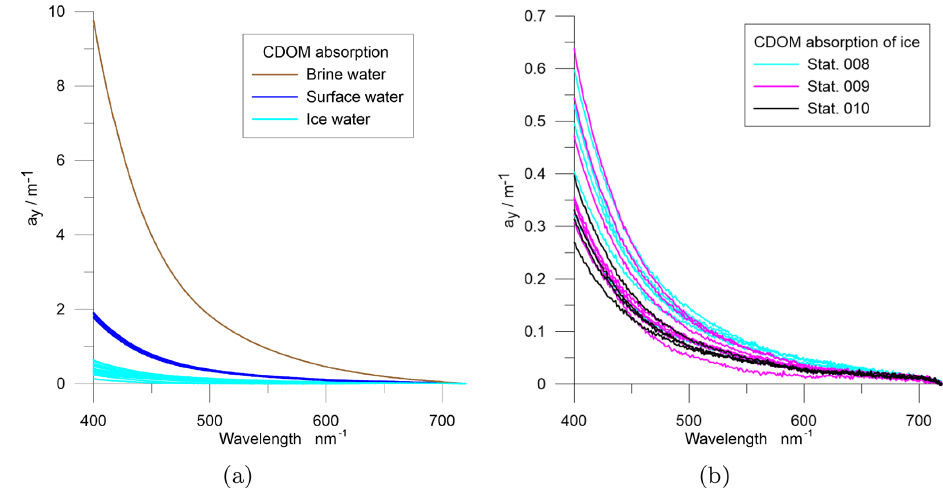
Figure 5. Spectral absorption at the sea ice stations including surface water from ice holes and CTD-rosette samples, brine, and water from different melted ice core sections at stations 8, 9, and 10 (Fig. 3). Panel (b) shows melted sea ice absorption separately.